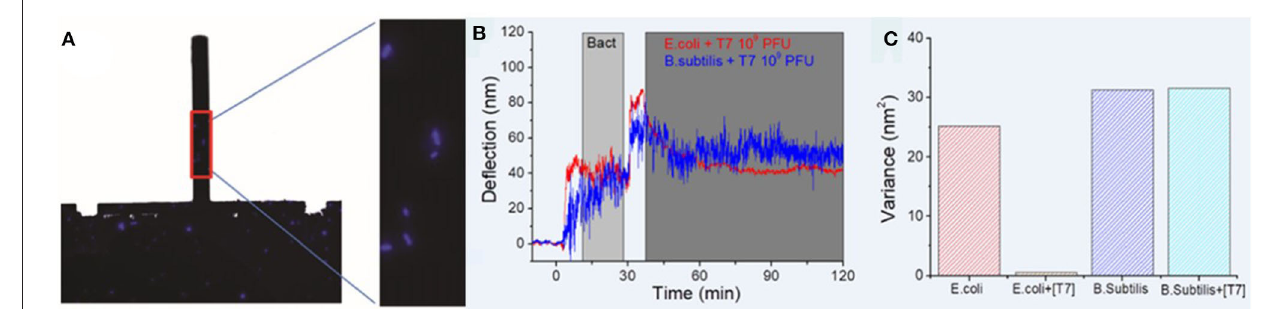
FIGURE 7 | Assessment of bacteria-bacteriophage interactions with nanomechanical sensors. (A) Fluorescence images of the whole chip and zoom showing a few E. coli cells attached to the poly-L-lysine coated cantilever. (B) Deflection vs. time for cantilevers coated with E. coli and B. subtilis exposed to T7 phages. (C) Signal variance for the bacteria-coated cantilevers, showing a drastic decrease in the case of E. coli exposed to T7 phages owing to viral infection. Reprinted from Mertens et al. (2019) with permission from the author.